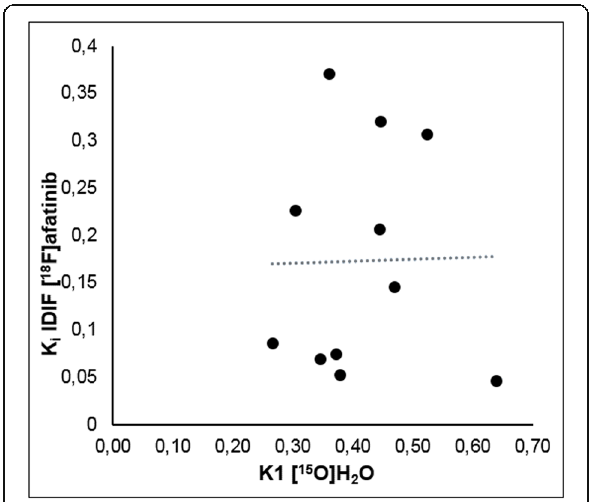
Fig. 4 Correlation between K i of [ 18 F]afatinib (IDIF) and K 1